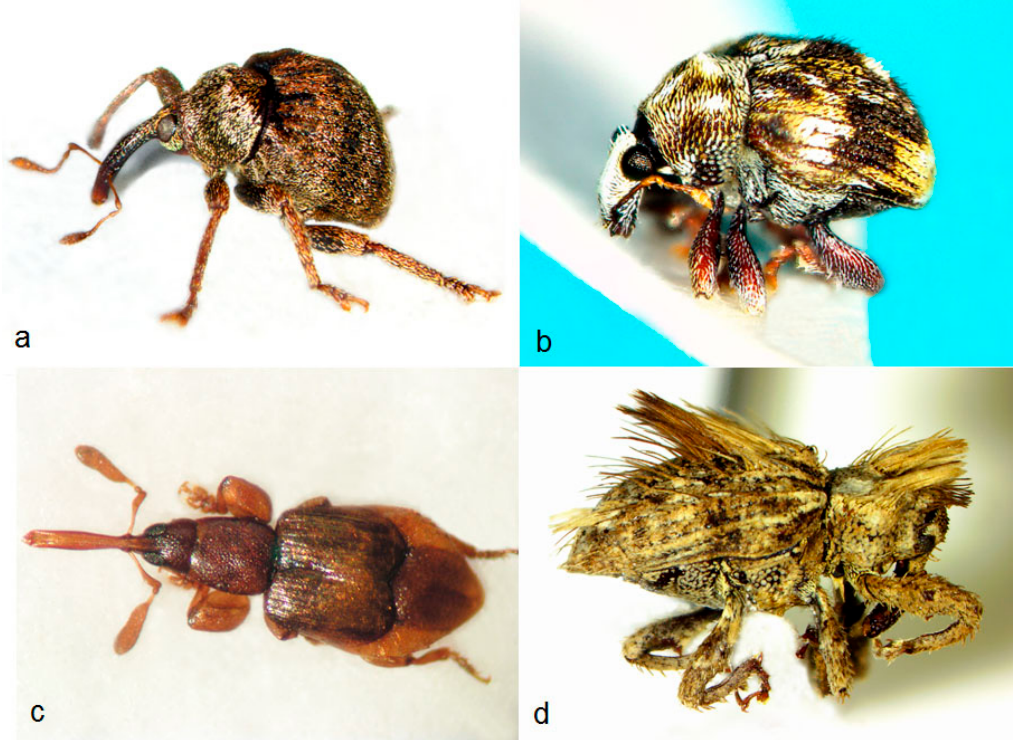
Figure 9. Weevils with doubtful assignments I. The first species ( a ) represents the Hyperini genus Phaeopholus ( confirmed by Ji ř i Skuhrovec). The second species ( b ) probably belongs to Microstylini, a tribe of rather uncertain placement (Curculioninae or Molytinae). The third species ( c ) has a very extraordinary habitus: small, flat, shortened elytra, very thick profemora, and a very long antennal club. There is also sexual dimorphism. The long-nosed female is shown. The assignment is unknown, perhaps Acalyptini (M.A. Alonso-Zarazaga, pers. comm.). The next species ( d ) is probably a Sophrorhinini species.